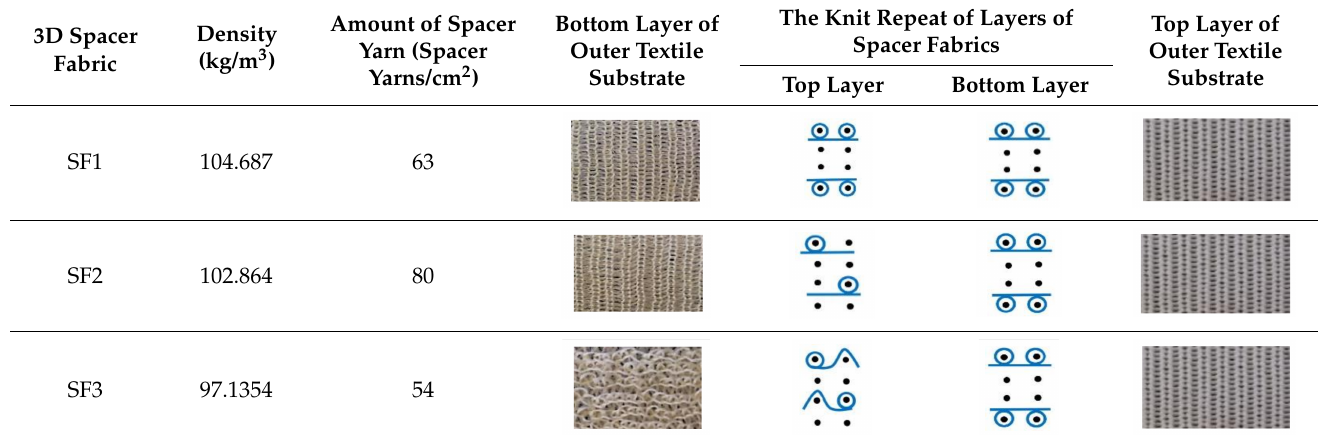
Table 1. Structure parameters and view of 3D spacer fabrics.